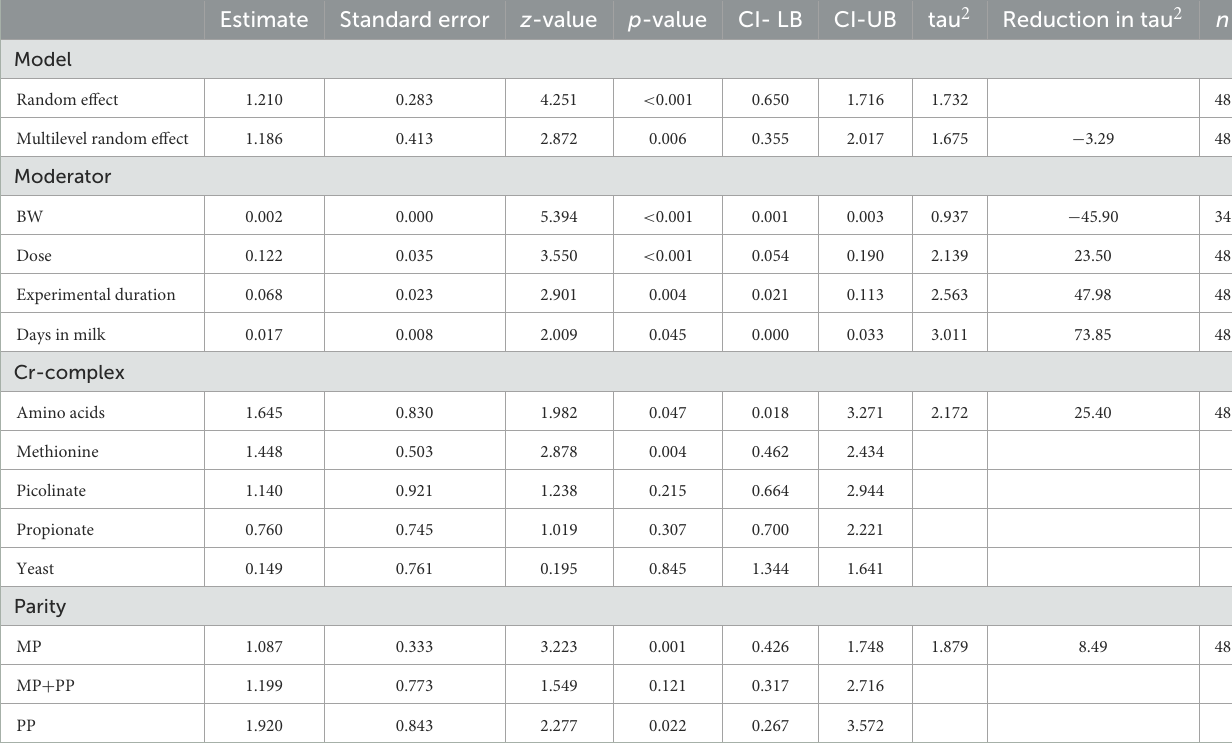
TABLE 2 A summary of statistical models and moderators for the milk production meta-analysis.